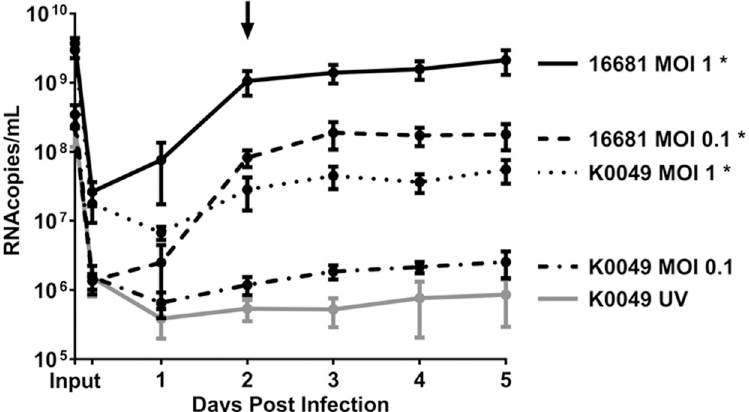
Fig 3. Dengue virus replicates in UT-7 cells. UT-7 cells were infected with DENV-2 16681 or DENV-2 K0049 at various MOIs. UT-7 cells incubated with UV-inactivated K0049 served as a control. Immediately following infection and daily post infection, supernatant samples were collected and DENV RNA was quantified via qRT-PCR. Data from three independent experiments are represented as the mean number of RNA copies per milliliter of cell supernatant. Error bars are 1 SEM. The arrow points to the timepoint at which we tested for and found infectious virus in all supernatants, except for those from cells treated with UV-inactivated K0049. Statistical significance was determined using a two-way ANOVA and multiple comparisons t-test (with Holm-Sidak correction). Statistical significance next to the virus strain name indicate that that infection was significantly different from the UV-inactivated control as assessed by two-way ANOVA. Significance at a specific timepoint indicates that the condition at that timepoint was significantly different from the UV-inactivated control via t-test but that the overall infection was not significantly different via ANOVA. � p < 0.05; �� p < 0.01; ��� p < 0.005; ���� p <